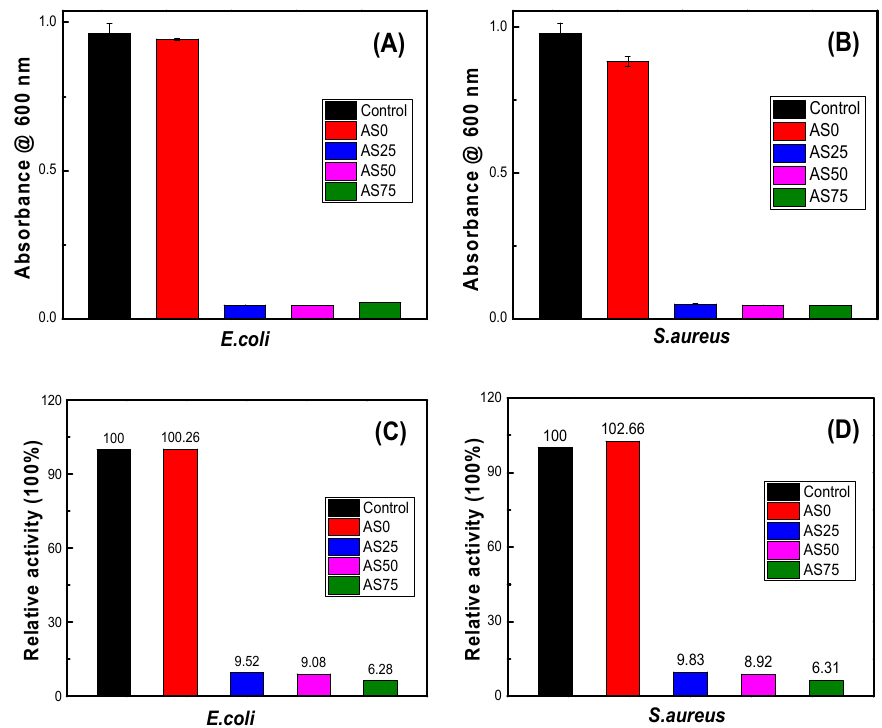
Figure 11. Quantitative analysis of proliferation of E.coli ( A ) and S.aureus ( B ), and the relative activity of E.coli ( C ) and S.aureus ( D ), culture in LB medium containing four groups of hydrogels. NIH3T3 cells were cultured in a medium containing hydrogels and the morphology of the cells